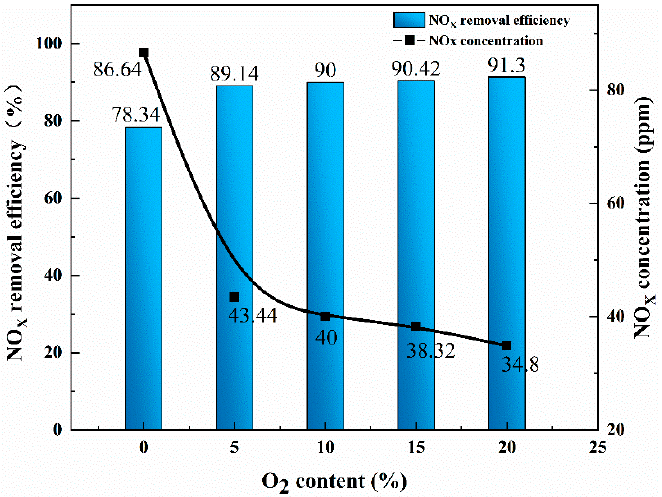
Figure 8. Effects of O 2 content in flue gas on NO X removal efficiency.